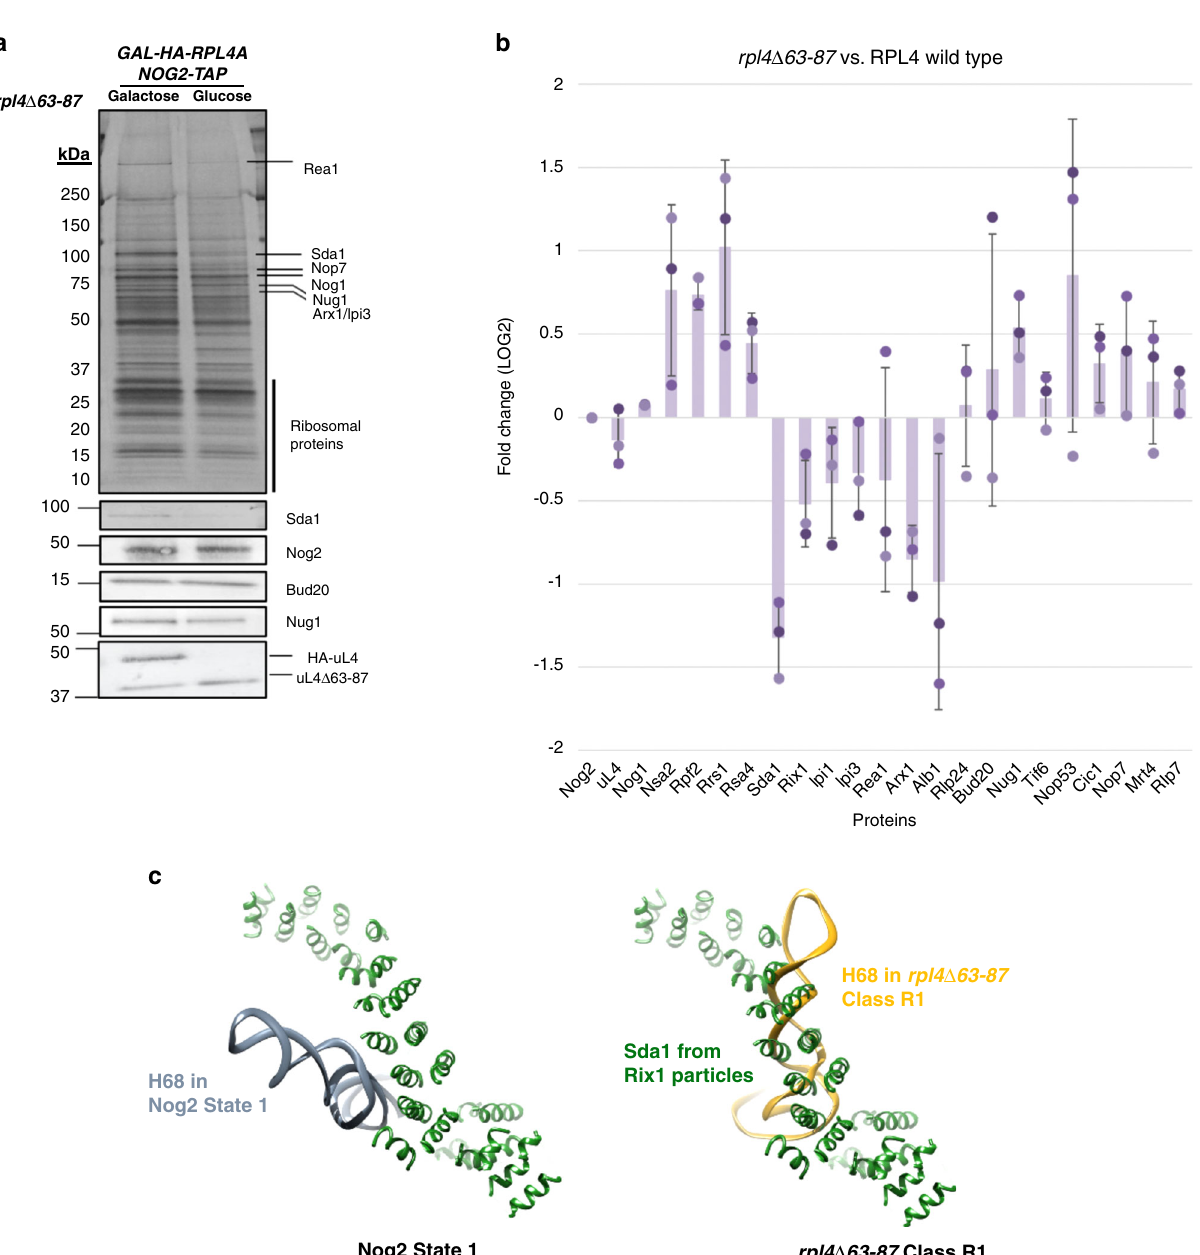
Fig. 4 Deviations in rRNA structure in rpl4 Δ 63 – 87 mutant particles result in H68 clashing with the binding site of Sda1. a SDS-PAGE gels followed by silver staining or western blotting show proteins in Nog2-associated particles puri fi ed from mutant rpl4 Δ 63 – 87 cells. Labeled bands were identi fi ed using mass spectrometry. b Samples prepared as in panel a were scaled up and subjected to semi-quantitative iTRAQ mass spectrometry to assay changes in relative amounts of pre-60S subunit proteins. Proteins were labeled with iTRAQ reagents and compared to wild-type counterparts. Each bar represents a biological replicate. All protein levels are normalized to the bait protein, Nog2. Ratios are represented on a log 2 scale. Error bars represent standard deviation ( n = 3). c The AF Sda1 (dark green) from Rix1 particles superimposed over wild-type Nog2 state 1 particles (left) and rpl4 Δ 63 – 87 mutant particles (right). H68 (gray for wild-type and gold for mutant) in rpl4 Δ 63 – 87 mutant particles clashes with almost the full length of observable